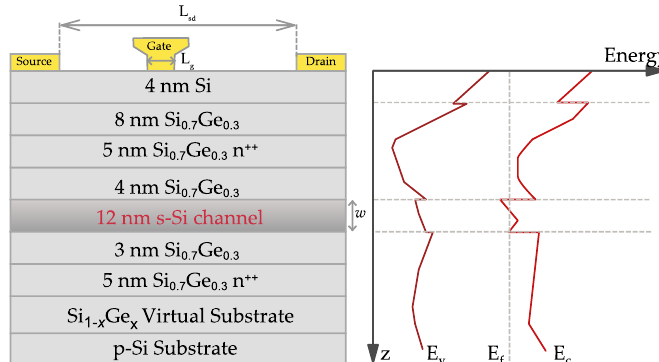
Figure 2. ( Left ) Cross section of the Si/SiGe MODFETs showing the vertical layout of the transistor with a schematic of the contacts; the strained-Si layer of thickness w is highlighted. ( Right ) A plot of the vertical profiles of both bands edges and the Fermi level under the gate in equilibrium is given; the double-deck supply layer structure leads to a double electron channel in the quantum well [32].